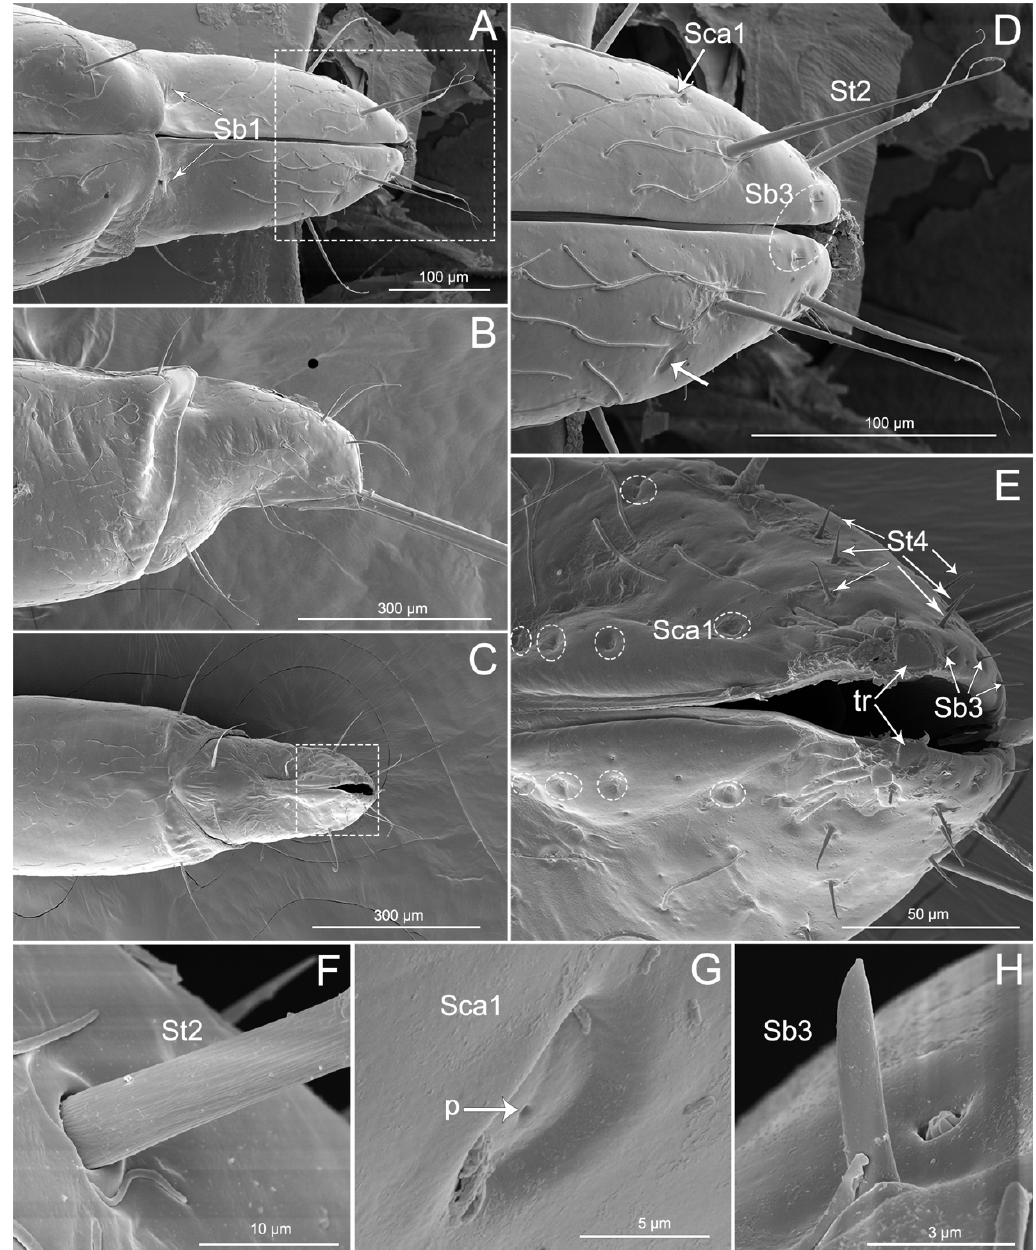
Figure 5. SEM of the fourth labial segment of Haematoloecha nigrorufa. A . Ventral view showing a pair of sensilla basiconica (Sb1); B . Lateral view; C . Dorsal view; D . Enlarged view of box in ( A ), showing sensilla trichodea (St2), sensilla campaniformia (Sca1) (white arrows) and sensilla basiconica (Sb3) (white circle); E . Enlarged view of box in ( C ), showing some sensilla campaniformia (Sca1) (white circles), sensilla trichodea (St4) and sensilla basiconica (Sb3); F . Enlarged view of sensillum trichodeum (St2); G . Enlarged view of sensilla campaniformia (Sca1); H . Enlarged view of sensilla basiconica (Sb3) and multilobular sensilla (Sm); p , pore. Thirteen types of sensilla were found on this segment, including three types of sensilla trichodea (St1, St2, and St4), five types of sensilla basiconica (Sb1, Sb3, Sb4, Sb5, and Sb6), three types of sensilla campaniformia (Sca1, Sca2, and Sca3), one type of sensilla placoid elongated (Spe), and one type of multilobular sensilla (Sm). There are many sensilla trichodea (St1) and multilobular sensilla (Sm) all over the segment IV dorsal, lateral, and ventral surfaces (Figure 5A–H). Five pairs of sensilla trichodea (St2) are found on segment IV (two pairs on the ventral surface, one pair on the lateral surface, and two pairs on the dorsal surface). Six pairs of sensilla trichodea (St4) are distributed on